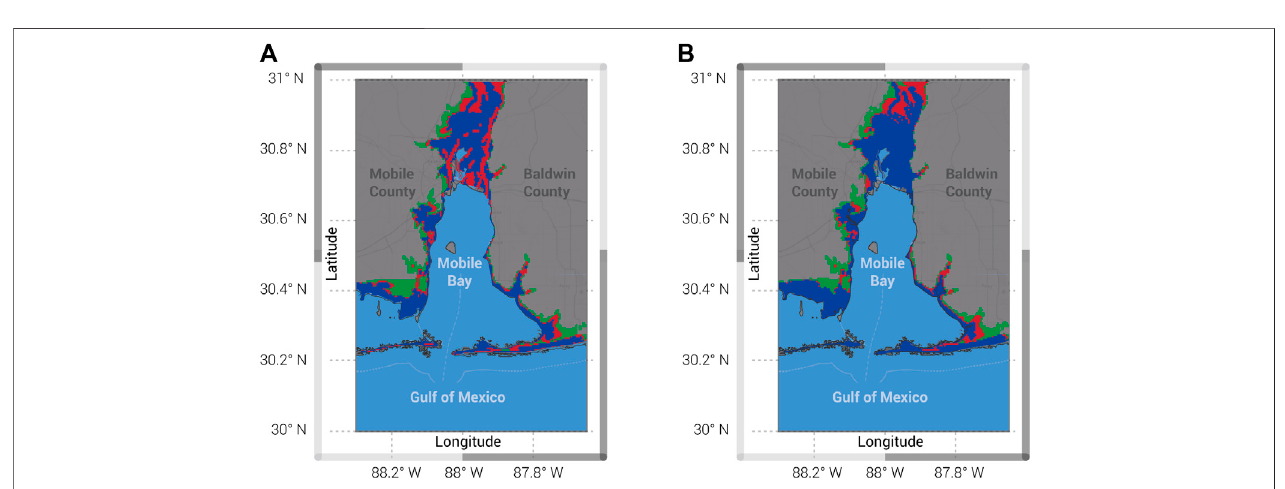
FIGURE 12 | Inundations for (A) natural Hurricane Katrina track and (B) shifted Hurricane Katrina track. Blue color dominates the area inundated by scenario S KN2005 for (A) and S KS2005 for (B) only; red representsthe extra area fl ooded by S KN2100-4.5 for (A) and S KS2100-4.5 for (B) . Green is the extraarea inundated byS KN2100- 8.5 for (A) and S KS2100-8.5 for (B) .